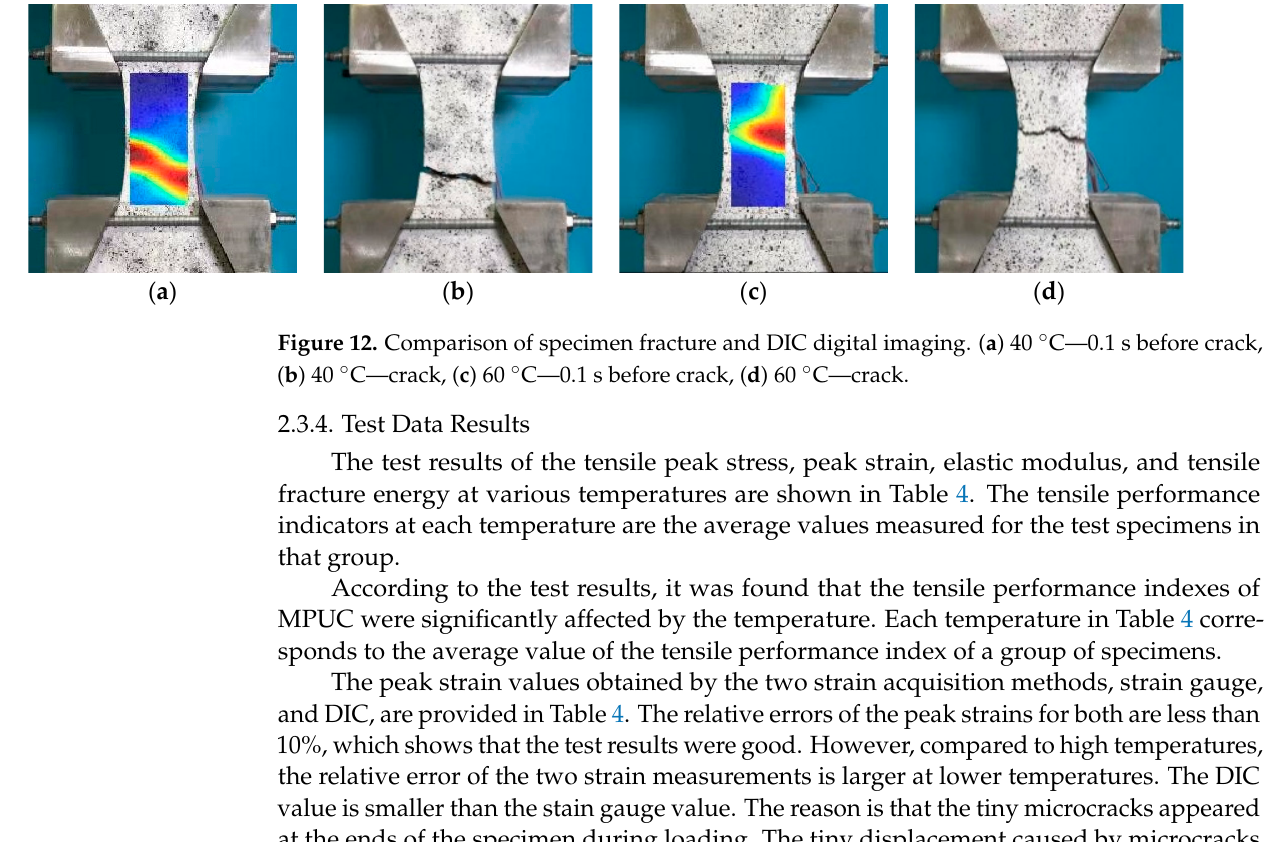
Figure 11. Fracture cross-section of the experimental specimen. ( a ) − 10 °C, ( b ) 15 °C, ( c ) 60 °C. The strain field of the specimen was calculated by the data of DIC, and the fracture position of the specimen was compared with the test results. The strain field of the specimen matched well with the test results, as shown in Figure 12.